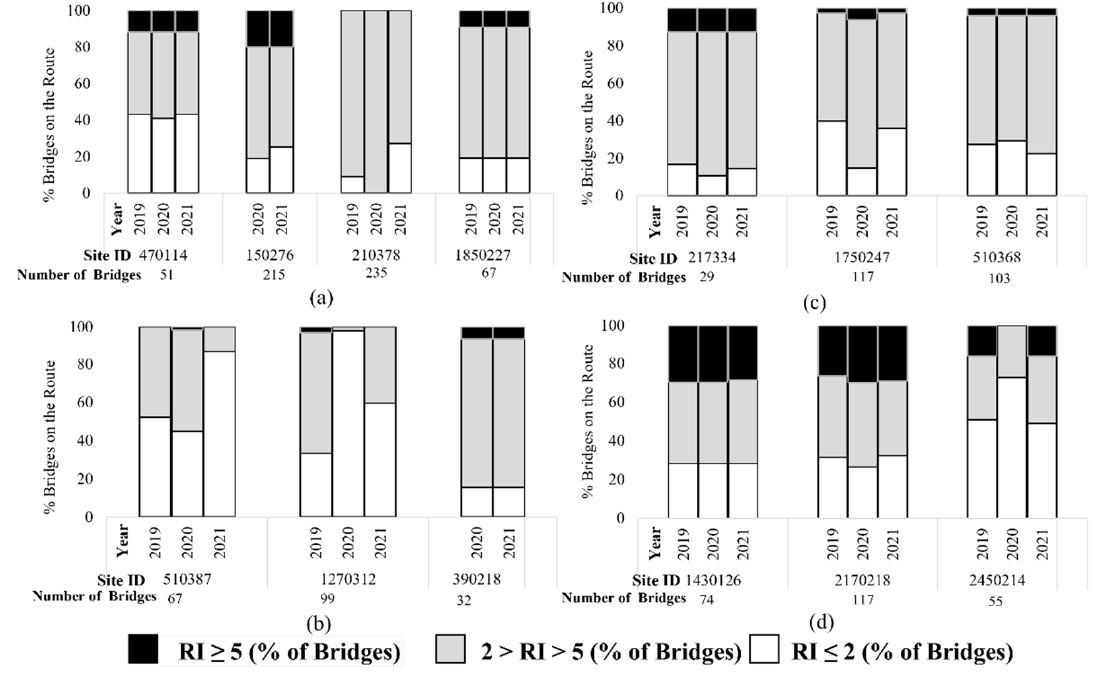
Figure 7. Bridge reliability in percentage for routes ( a ) I-75, ( b ) I-95, ( c ) I-16, and ( d ) I-20.